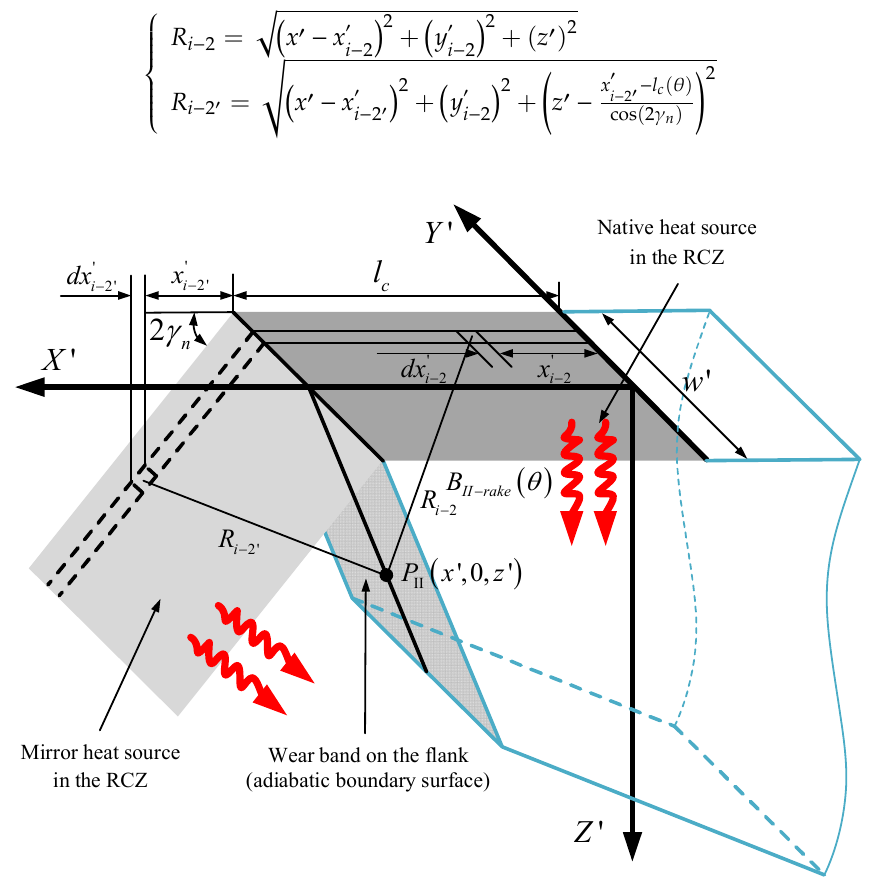
Figure 5. Heat source in the RCZ.